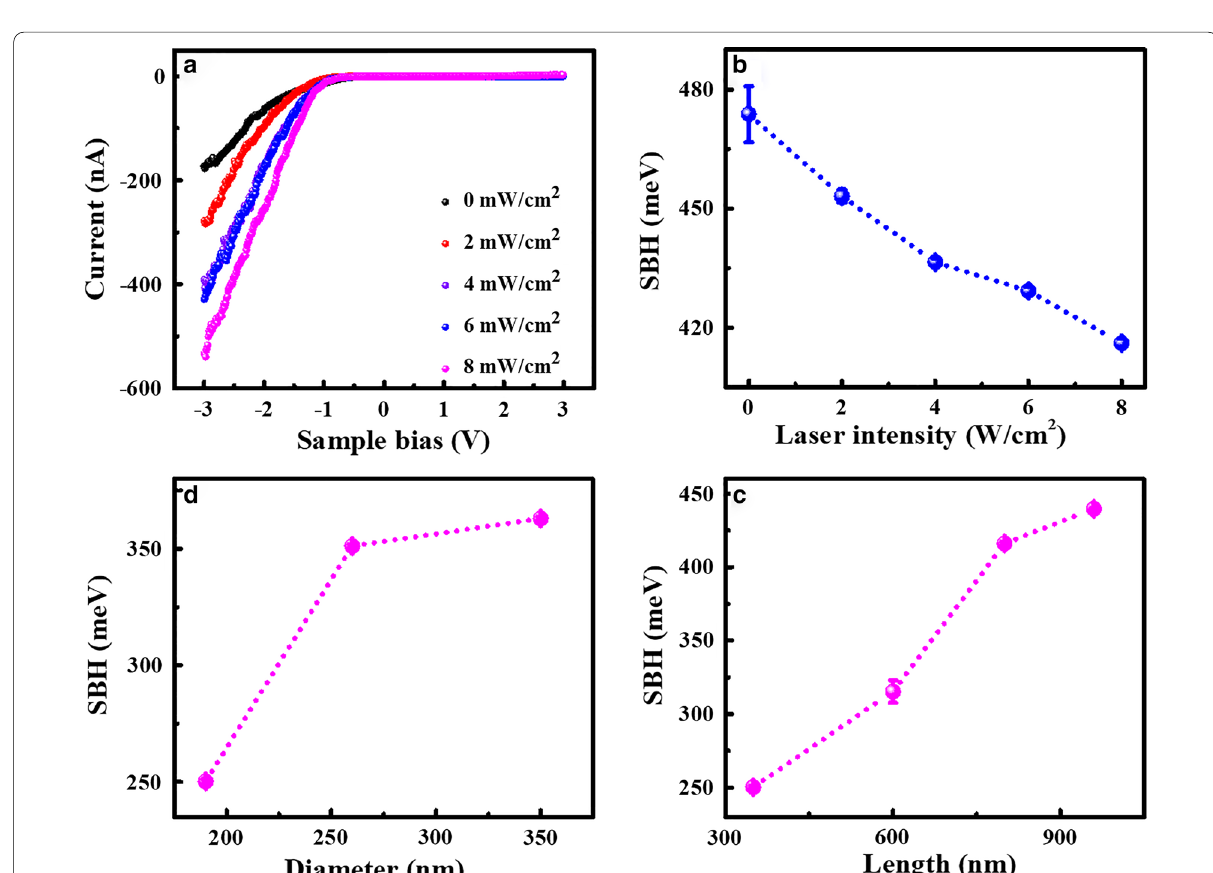
Fig. 4 a Typical I–V curves of Si NWs with 190 nm in diameter and 800 nm in length under different laser irradiation. b SBH values obtained from the fitting of I–V curves in a . The diameter- and length-dependent SBH values under 8 W/cm 2 laser irradiation are plotted in c , d ,